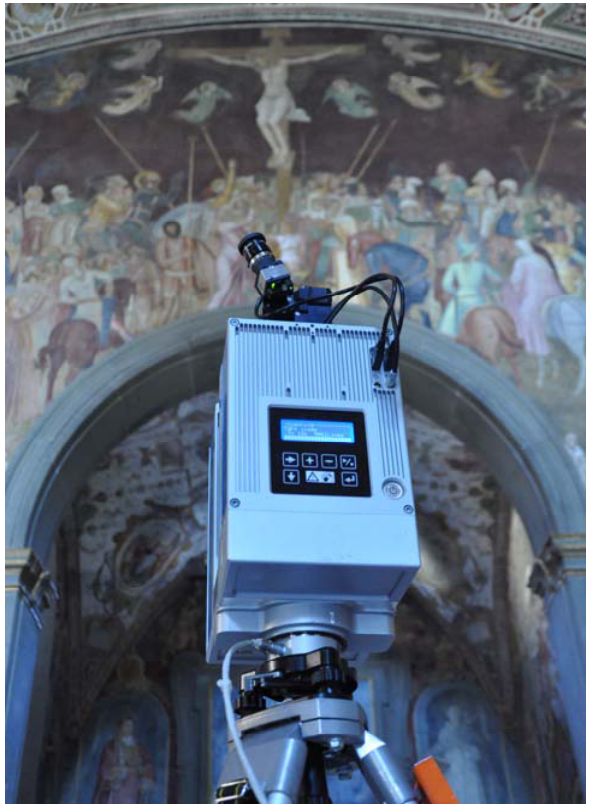
Figure 1. Laser scanner Z+F Imager 5006i